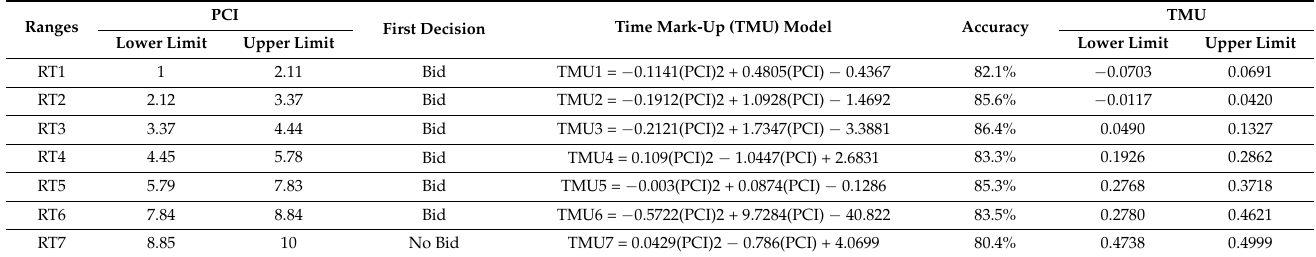
Table 8. Relation between the PCI and TMU based on data from 111 projects.